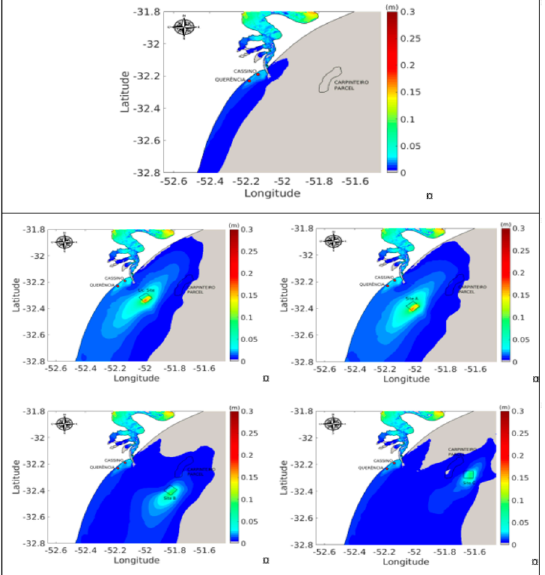
Figure 11. Top panel—Bottom evolution for the simulation performed without considering discharge operations, representing the natural contribution of suspended sediment from Patos Lagoon. Bottom panel—Bottom evolution for the simulations performed considering discharges in the licensed and alternative disposal Sites A, B, and C. Color scale indicates bottom evolution (m). Marked points Cassino and Quer ê ncia indicate points from where bottom evolution time series were extracted for further